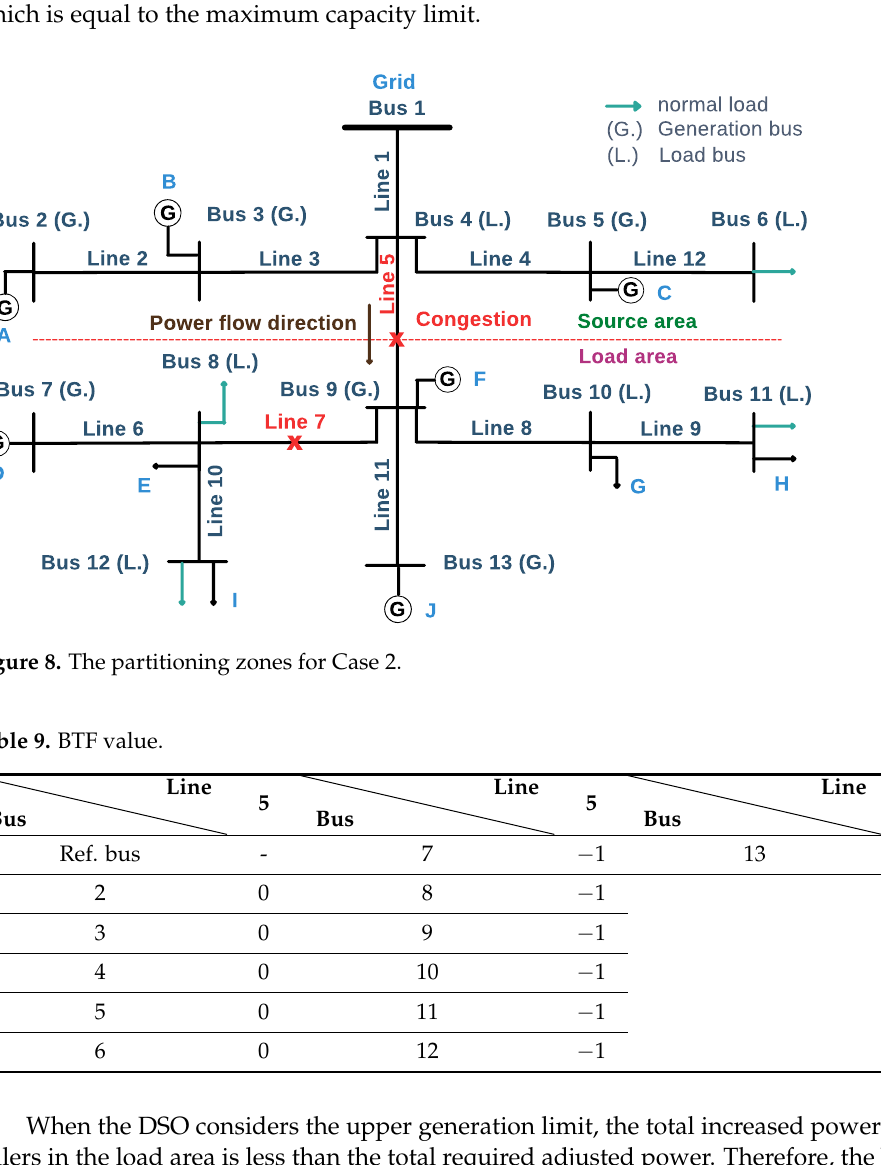
Table 9. BTF value.